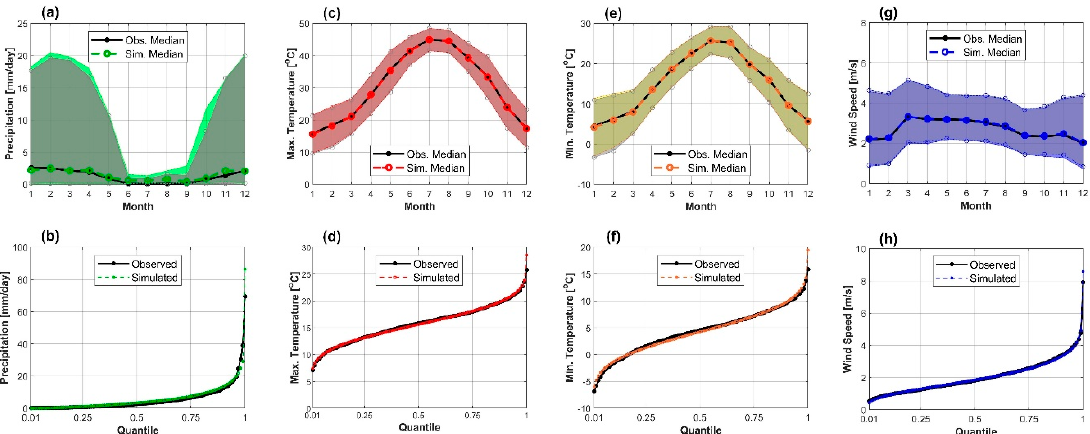
Figure 7. Comparisons of the daily observed and simulated values for the medians with daily 0.05 and 0.95 quantiles in the bounded areas, and the CDF − 1 for the four weather variables.